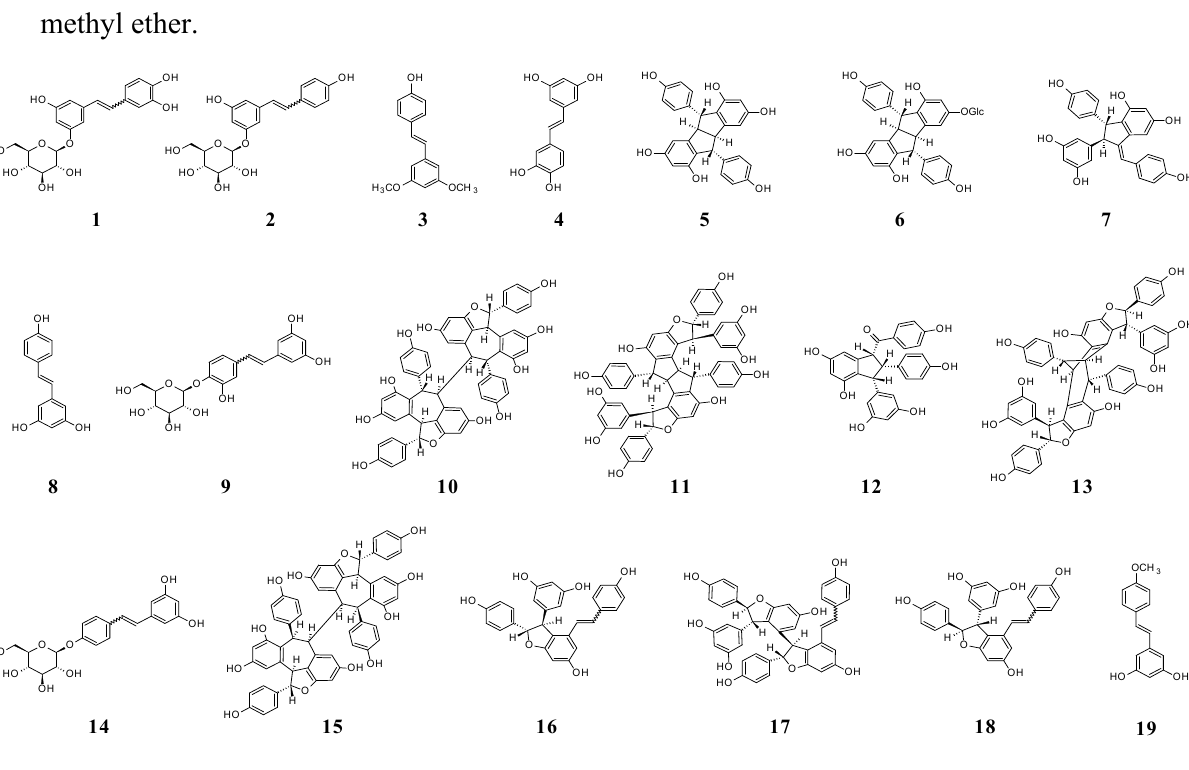
Figure 5. Structures of stilbenes in grape. ( 1 ) Z- and E-astringin; ( 2 ) Z- and E-piceid; ( 3 ) pterostilbene (3,5-dimethoxy-4'-hydroxystilbene); piceatannol; pallidol; ( 6 ) pallidol-3- O -glucoside; ( 7 ) parthenocissin A; ( 8 ) trans -resveratrol; ( 9 ) resveratroloside;